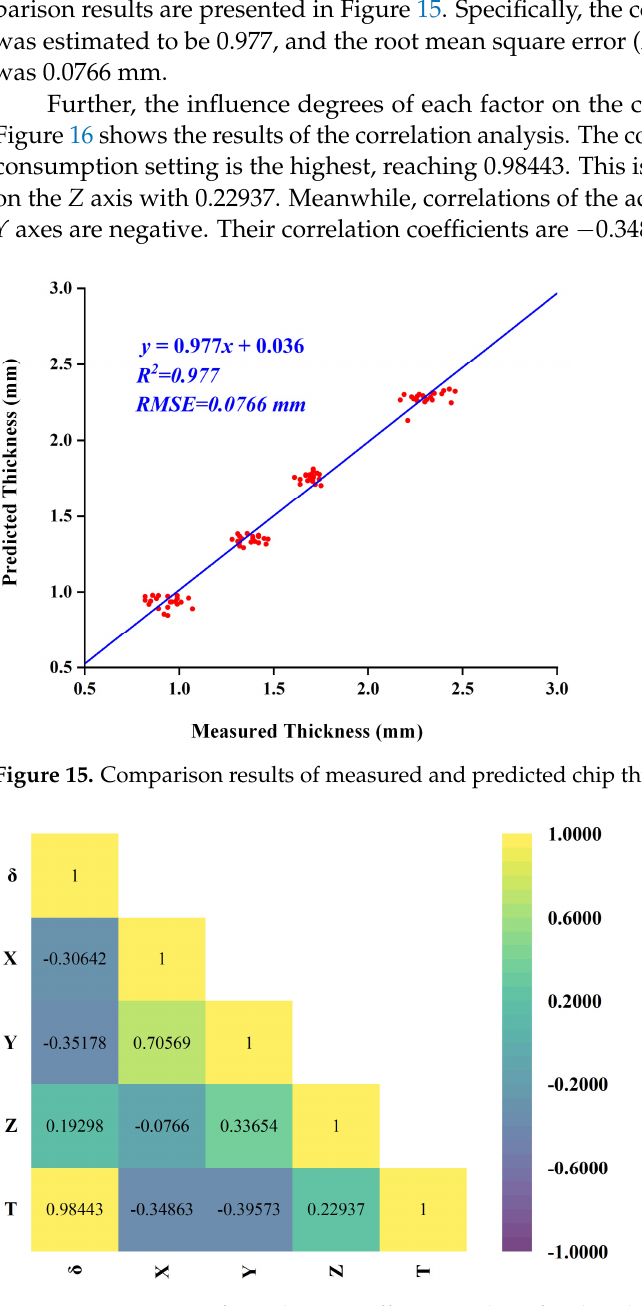
Figure 16. Heat-map of correlation coefficient analysis for chip